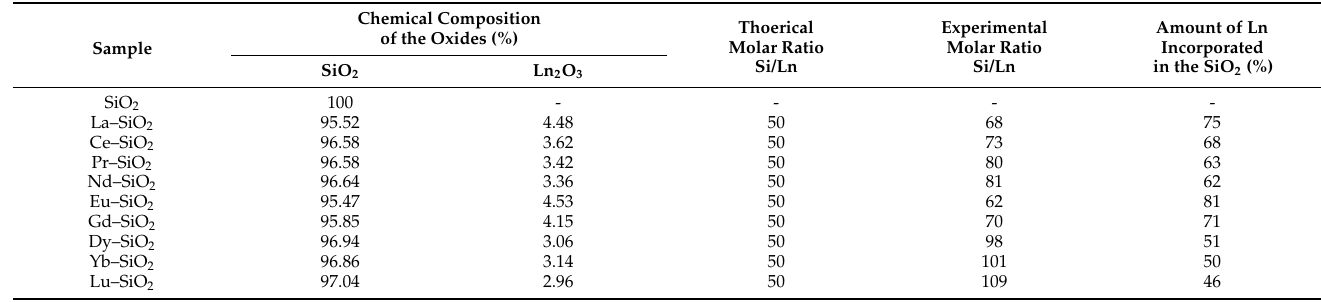
Table 1. Chemical composition of the SiO 2 and Ln–SiO 2 , obtained from XRF spectra. Chemical Composition of the Oxides Sample